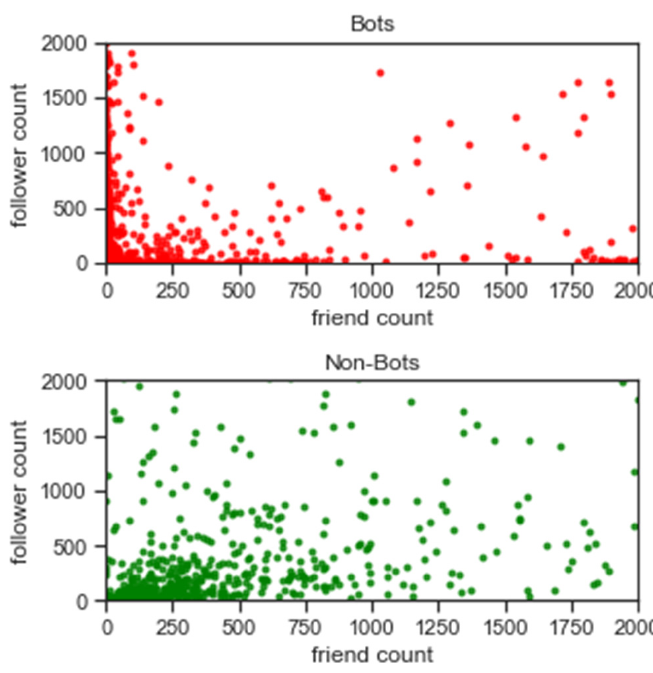
Figure 8. Follower against Friend count for Bots and Non-bots.